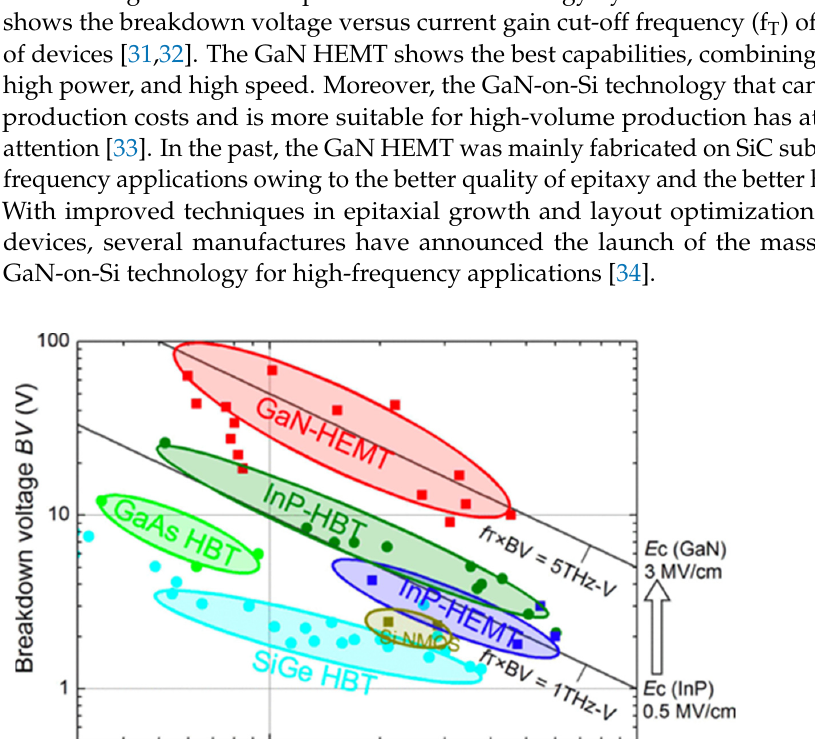
Figure 4. Lattice parameters and band gap for GaN-AlN-InN alloys [22]. (Data from [22]).